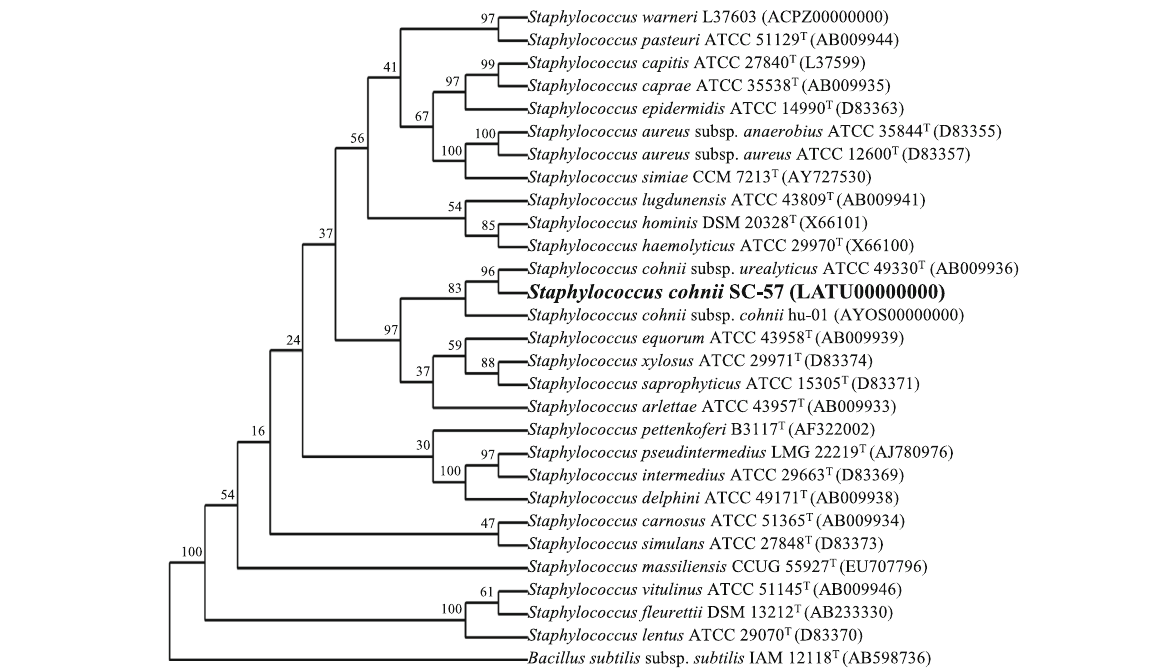
Fig. 2 Phylogenetic tree based on 16S rRNA gene sequences of the genus Staphylococcus . The names and corresponding accession numbers are shown, including the S. cohnii (SC-57) sequence from this study, which was 100% similar to SC-532. Sequences were aligned using Clustal W2 and MUSCLE [13] and uploaded in DAMBE [15] to build a phylogenetic tree using a Maximum Likelihood method with the GTR substitution model, rate heterogeneity among sites modeled by a gamma distribution, and 1000 bootstrap samples. The number at the nodes represents bootstrap support. Generated with the ‘ Quick add ’ option on, and the number of branches allowed to cross during tree searching set to 1